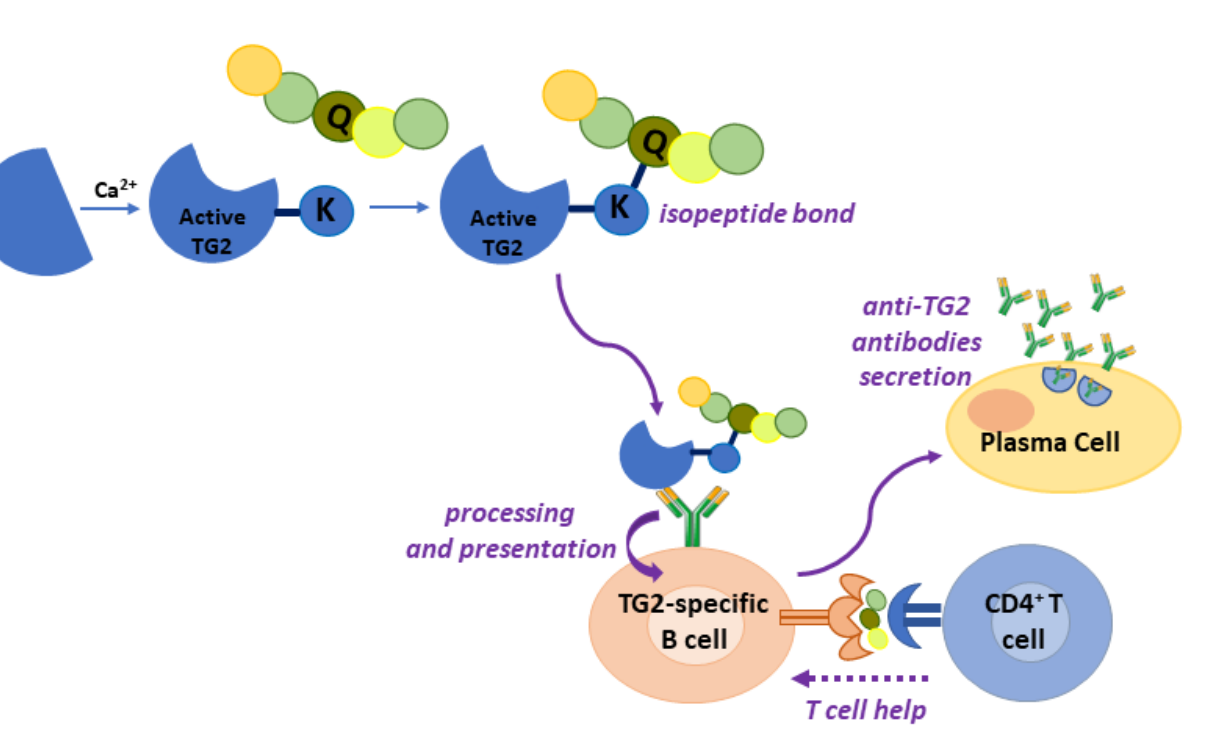
Figure 4. Gliadin peptides deriving from covalent complexes between TG2 and gliadin are presented by TG2-specific B cells, thus activating gliadin-restricted CD4 + T helper cells, which, in turn, stimulate plasma cell maturation and autoimmune response against TG2.